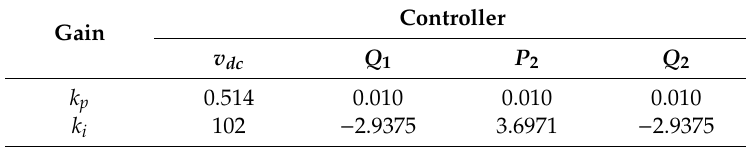
Table 3. Proportional and integral (PI) controller’s parameters for outer